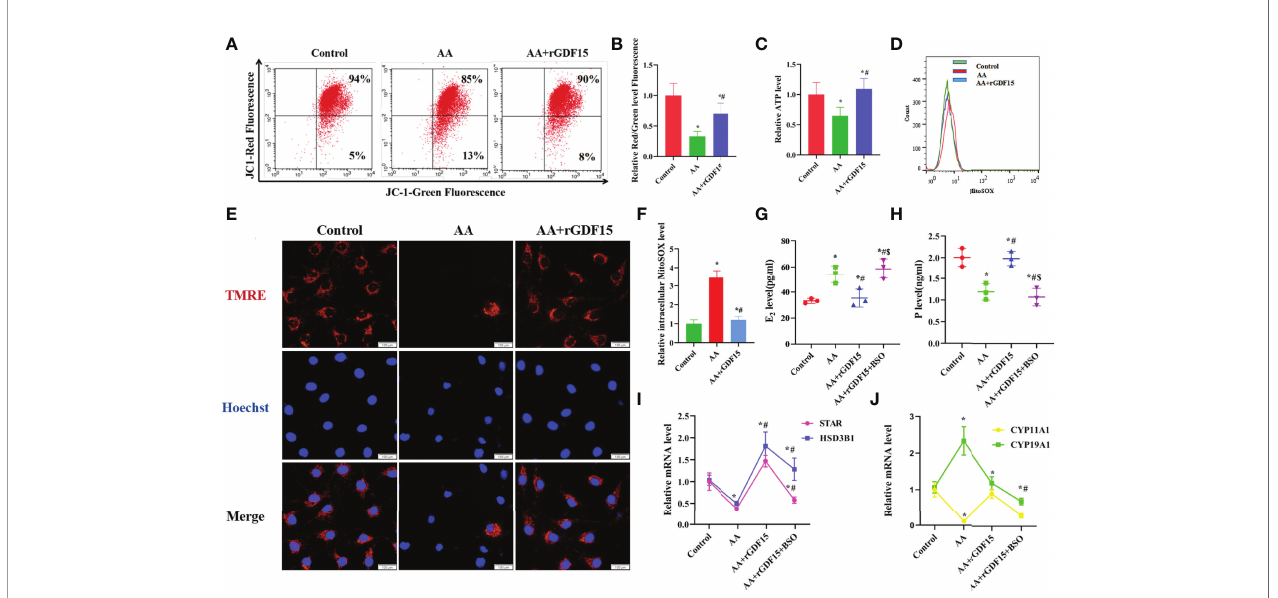
FIGURE 9 | Supplementation with exogenous rGDF15 restored secretory and mitochondrial functions of KGN cells caused by AA. (A, B) Supplementation with exogenous rGDF15 restored mitochondrial membrane potential (C) Supplementation with exogenous rGDF15 improved the ATP level of KGN cells. (D, F) Replenishment of rGDF15 decreased level of intracellular mitoSOX. (E) The TMRE level in KGN cells was measured after AA inhibition and addition of exogenous rGDF15 (G – J) Replenishment of rGDF15 ameliorated the secretory function produced by AA, restoring the secretory of E 2 and P along with the aberrant expression of STAR, CYP11A1,HSD3B1 and CYP19A1. When supplementation with exogenous GSH synthesis inhibitor BSO hinder this amelioration of secretory function, the rescue of the rGDF15 on E 2 and P secretion was interrupted together with the attenuated ability of in restoring STAR, CYP11A1,HSD3B1and CYP19A1 mRNA levels. Data represent mean ± standard error, *P < 0.05, * # P < 0.05, * #$ P < 0.05,Bar = 100 m